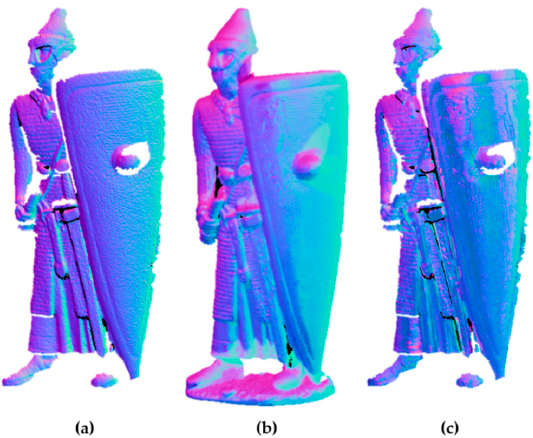
Figure 8. Normal maps. ( a ) Normal vector obtained by stereo vision; ( b ) Normal vector obtained by traditional photometric stereo; ( c ) Normal vector obtained by photometric stereo using re-projection images.